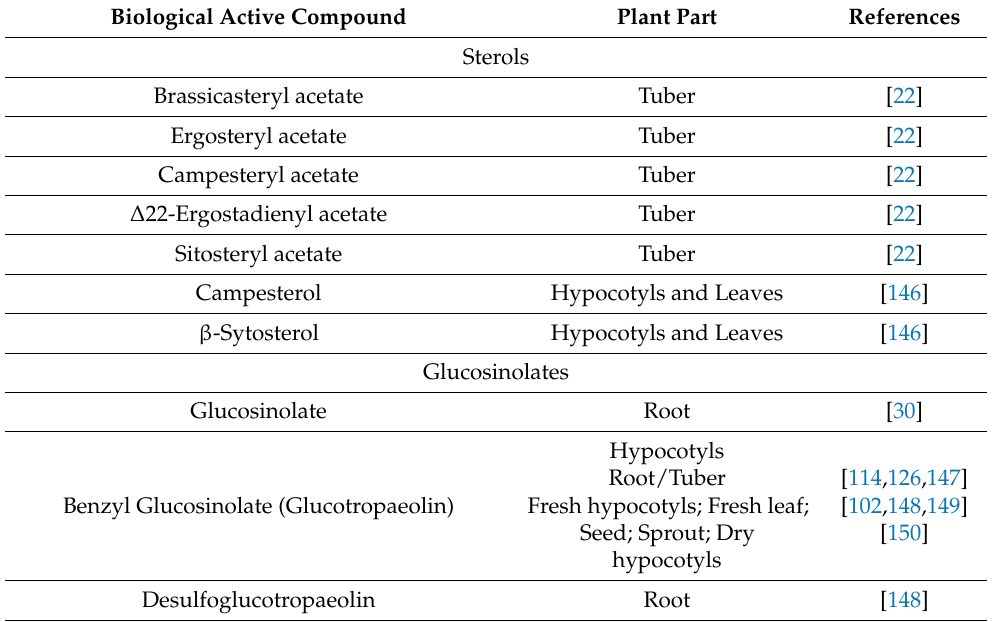
Table 2. Bioactive compounds in Lepidium meyenii